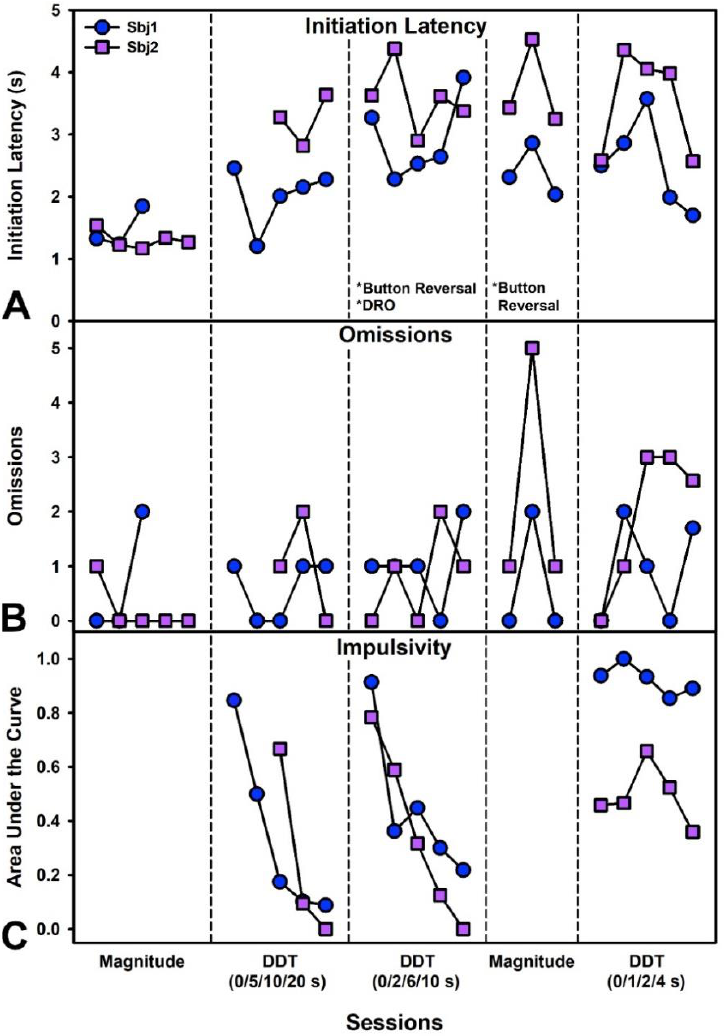
Figure 2. Performance on the Delay Discounting Task (DDT) for two male pigs (Experiment 1). Partitions from left to right indicate performance during a magnitude discrimination (only large versus small buttons, no delays), performance on the DDT with delays of 0, 5, 10, or 20 s (incrementing every 12 trials within the session), performance on the DDT with delays of 0, 2, 6, or 10 s after reversing the levers and giving marshmallows on a differential reinforcement of other (DRO) behavior schedule, performance on a second magnitude discrimination after reversing levers, and finally performance on the DDT with delays of 0, 1, 2 and 4 s. ( A ) Mean latency per session to initiate trials after a tone played indicating button availability. Latencies increased once delays were introduced. ( B ) Total omissions per session. Omissions remained relatively low throughout testing. ( C ) Area under the discounting curve which indicates the proportion of large/delayed/self-controlled choices made. Pigs made progressively more impulsive choices during the first set of delays but performed better at the low delays trained at the end.